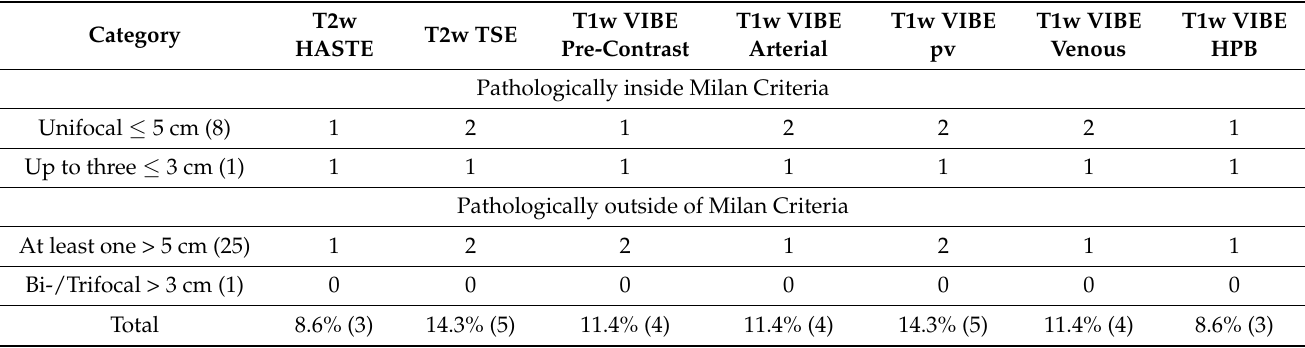
Table 5. Misclassification regarding the Milan criteria ( n = 35).